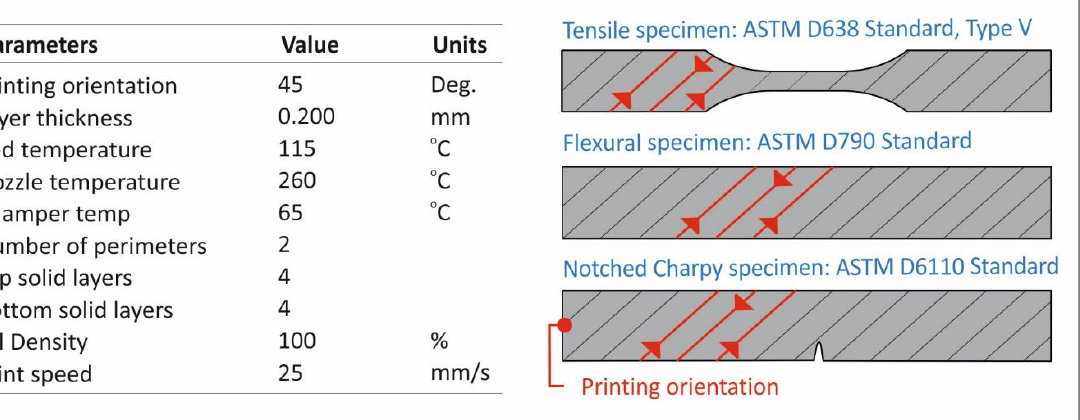
Figure 2. Fundamental FFF processing parameters selected for the fabrication of 3D-printed specimens of all tested mate- rials.